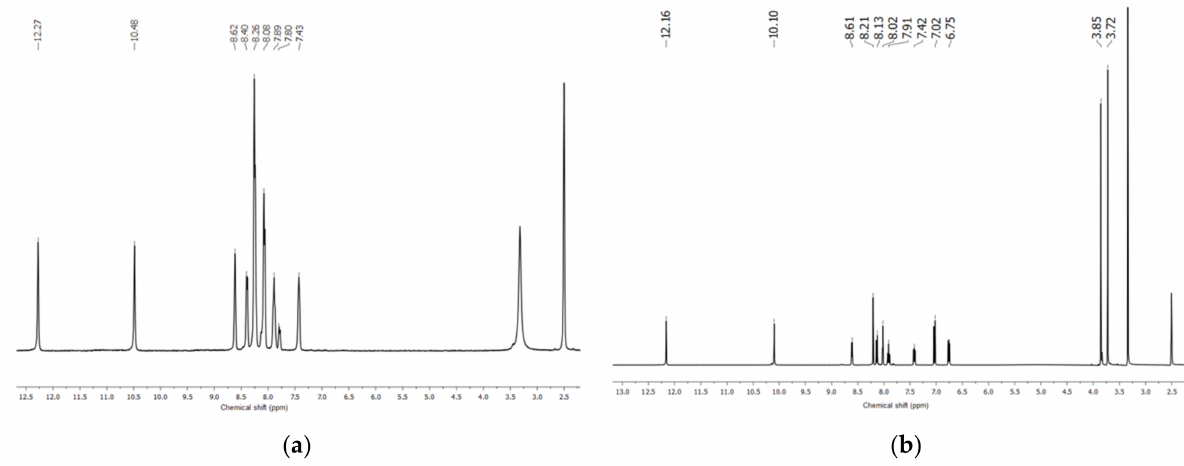
Figure 2. 1 H NMR spectra of HL 1 ( a ) and HL 2 ( b ) measured in DMSO-d 6